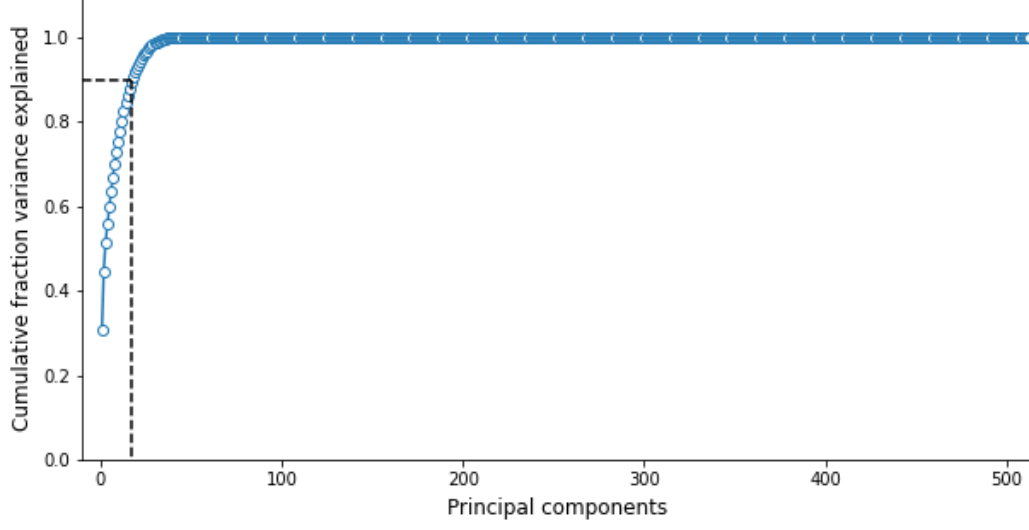
Figure 15. Cumulative fraction variance explained by each principal component from CNN feature extraction with contrast-based learning (Method II), for a window length of 150 time steps.